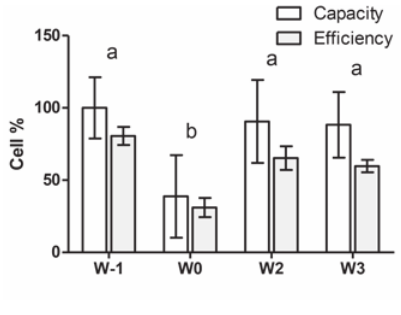
Figure 1. Phagocytic capacity and efficien- cy of hemocytes from Mytilus edulis according to spawning period. Mussels were sacrificed one week before (W-1) spawning, during (W0) spawning, two and three weeks after spawning period (W2 and W3, respectively).Different letters indicate, for capacity and efficiency, a sig- nificant difference (ANOVA,